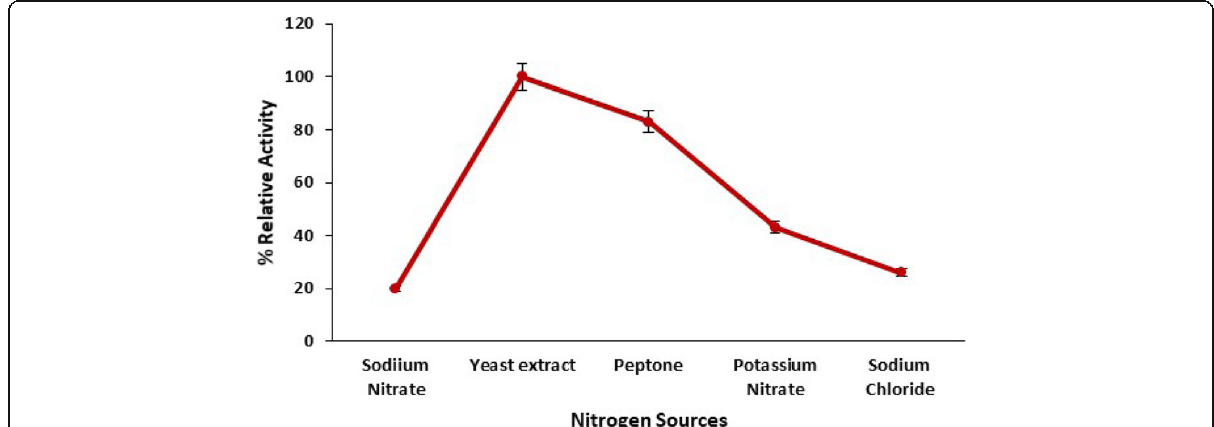
Fig. 2 The influence of nitrogen sources on pectinase production by B. licheniformis KIBGE-IB3 using date fruit wastes as substrate (means ± S.E., n = 6)